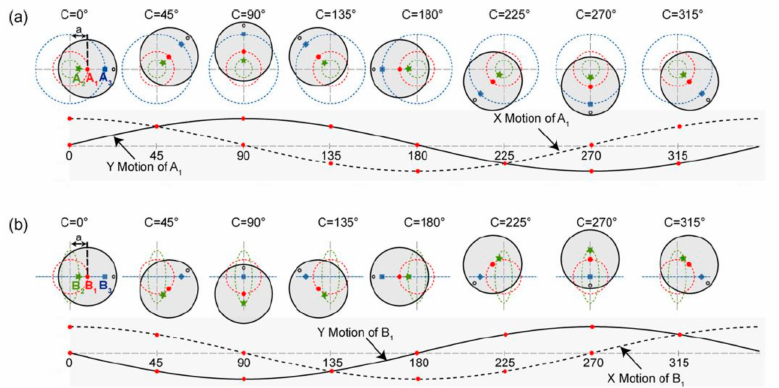
Figure 50. Comparison between the ideal spindle ( a ) and the spindle with significant radial error movement ( b )